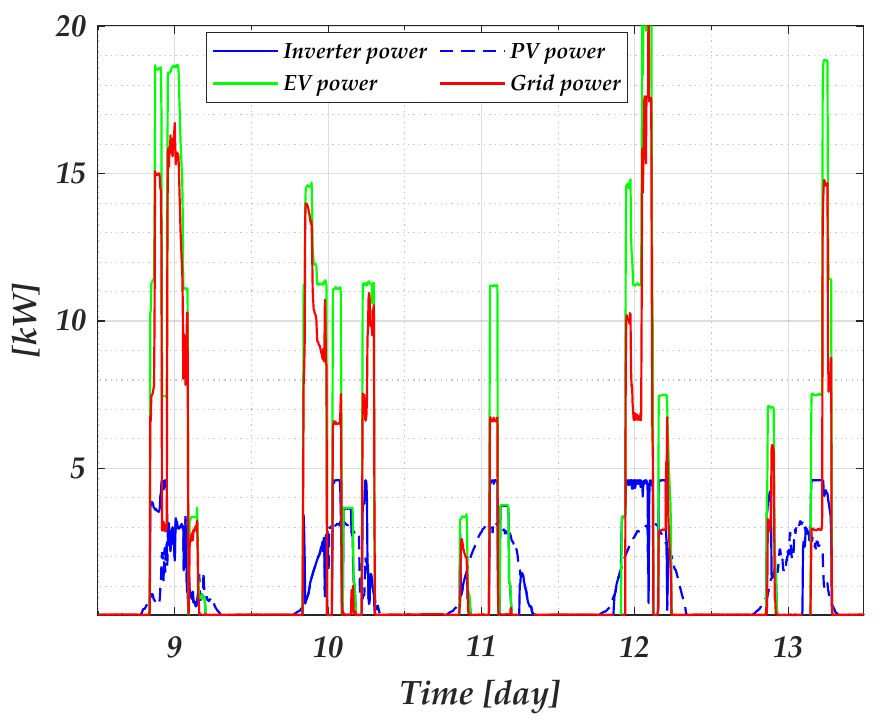
Figure 4. Normal operation power profile of the charging station (9th to 13th of May 2022) using the conventional EMS.